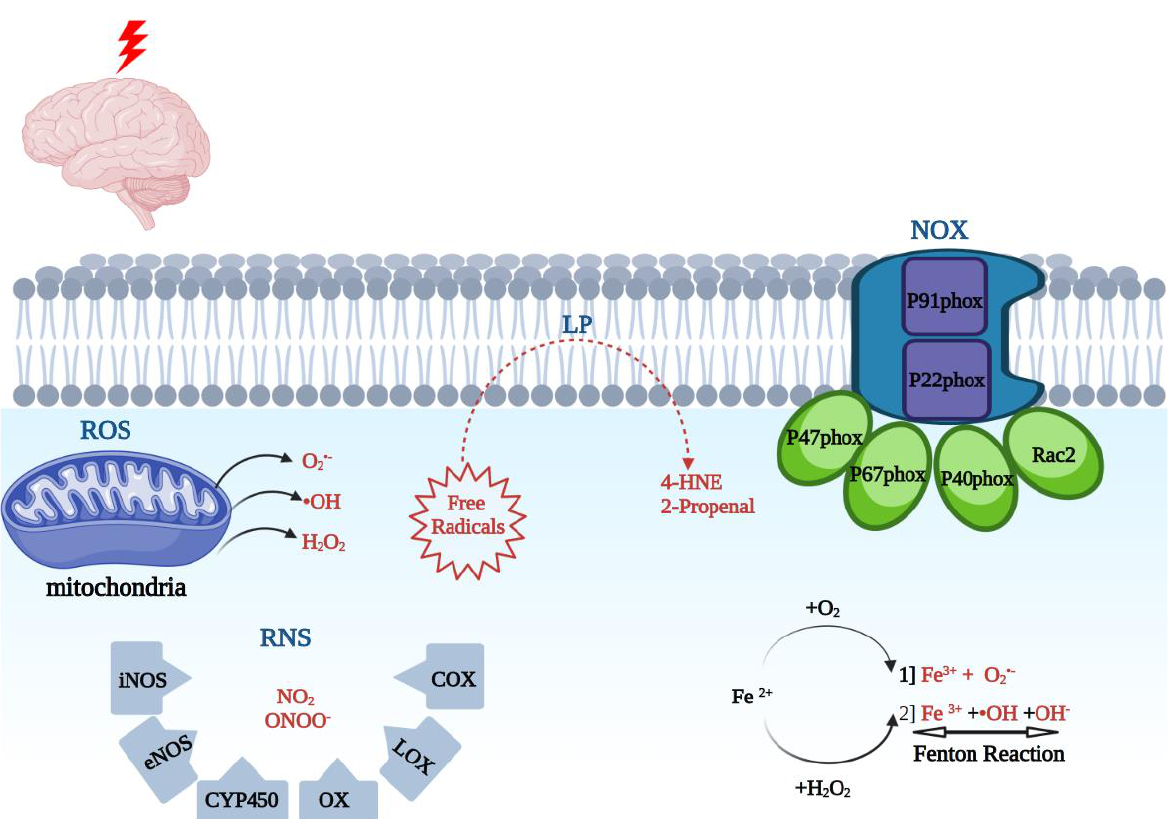
Figure 1. Schematic illustration of the main cellular components involved in the post-TBI oxidative stress process. The NAPDH oxidase (NOX) with its two membrane subunits, P91phox and P22phox, and cytoplasmic components, P47phox, P67phox, P40phox, and Rac2, is a key enzymatic unit involved in this process. The reactive oxygen species (ROS), comprised of superoxide (O2 •− ), hydrogen peroxide (H 2 O 2 ), and the hydroxyl radical ( • OH), are products of 1-electron reduction of oxygen. The reactive nitrogen species (RNS), including various nitric oxide compounds, such as peroxynitrite (ONOO - ) and nitrogen dioxide (NO 2 ), are the products of multiple enzymes including nitric oxide synthase (iNOS), endothelial nitric oxide synthase (eNOS), cytochrome P450 (CYP450), cyclooxygenase (COX), lipoxygenase (LOX), and xanthine oxidase (XO). Free iron (Fe 2+ ), an abundant ion within the CNS, participates in two main reactions, including the Fenton reaction, leading to the production of Fe 3+ , O2 •− , • OH +, and OH − . The phenomena of lipid peroxidation (LP) involves electron transfer from membrane lipids to free radicals, involving a three-step process, and ultimate production of 4-HNE and 2-propenal (acrolein). The free radicals are depicted as red vs. the enzymes and proteins are in black. Images created with Table 1. Outlines the main pathological agents involved in TBI oxidative stress, and their corre- sponding proposed mechanisms.